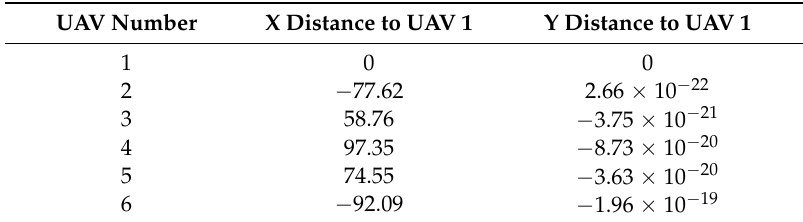
Table 2. Optimization results of indicator